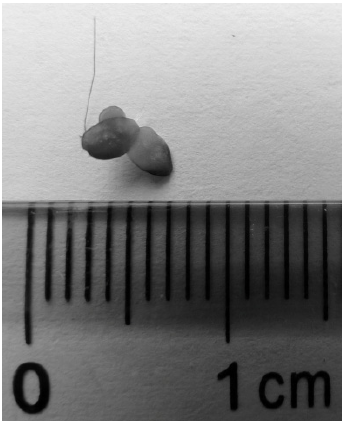
Figure 1. The duckweed L. punctata